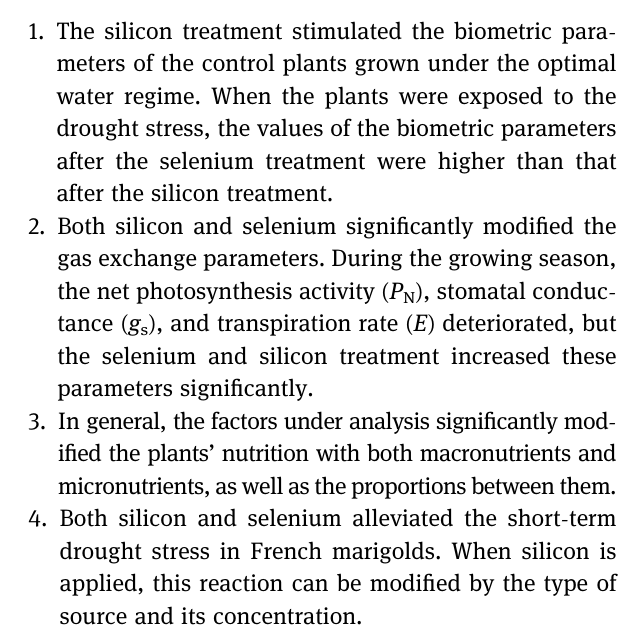
Table 9: The quantitative relations between microelements and silicon in shoots and in fl orescences of Tagetes patula L. “ Pascal. ” For each combination the Fe content was taken as